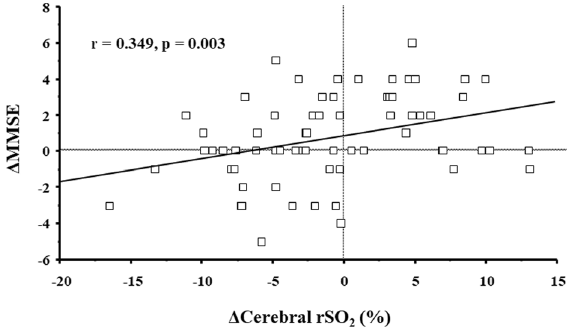
Figure 2. Correlation between changes in MMSE score and changes in cerebral rSO 2 from the study initiation to the second measurement. ΔMMSE MMSE score at the second measurement − MMSE score at the study initiation, ΔCerebral rSO 2 cerebral rSO 2 at the second measurement − cerebral rSO 2 at the study initiation, MMSE Mini-Mental State Examination, rSO 2 regional oxygen